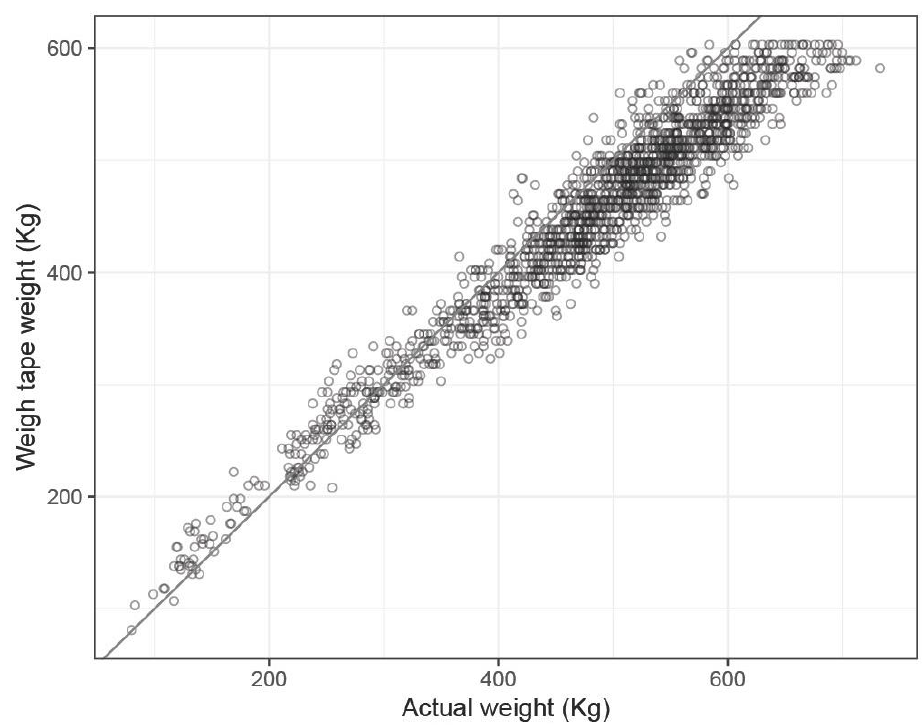
Figure 2. The weigh tape readings compared to the actual weights of 1716 horses. The grey line is an ‘identity line’, where those points which perfectly agree would lie.